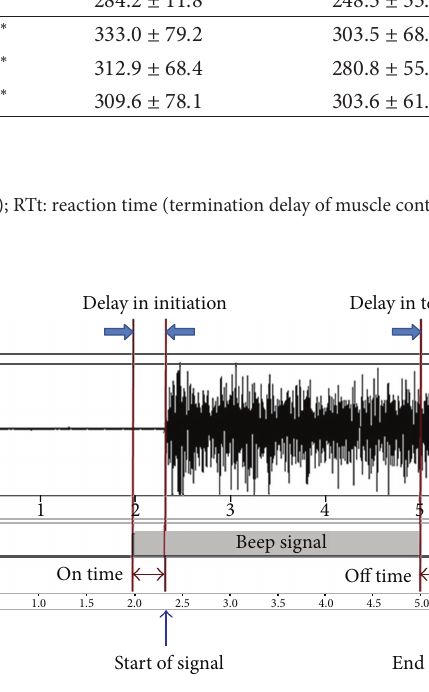
Figure 2: Example of an EMG signal used for RT measurement. The participantswereinstructedtostartandquitthevoluntaryisometric muscle contraction as quickly as possible when they recognized an auditory beep “on” and “off.” RTi (delay in initiation) was defined as the time interval between the onset of the beep and the onset of EMG contraction signal. RTt (delay in termination) was defined as the time interval between termination of the beep and termination of the EMG